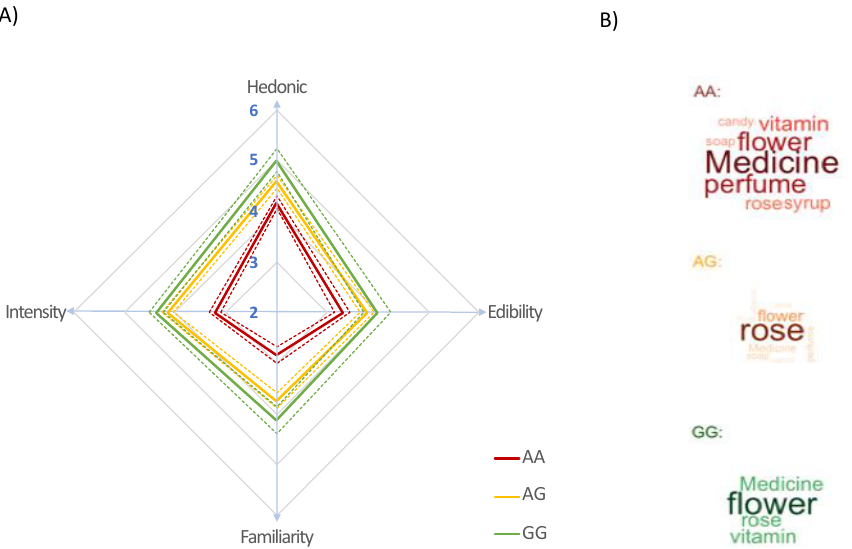
Figure 1. Perceptual evaluations of βI at a supraliminal concentration by Malagasy participants according to their genotype. All participants meeting the inclusion criteria are shown here ( n = 235). ( A ) Average ratings on the perceptual scales (Hedonic, Edibility, Familiarity, and Intensity), mean (solid lines) standard error of the mean (dashed lines). ( B ) Word clouds of descriptors used by the participants according to their genotype (AA, AG, and GG). The size of each descriptor is proportional to the frequency of its usage by the participants.